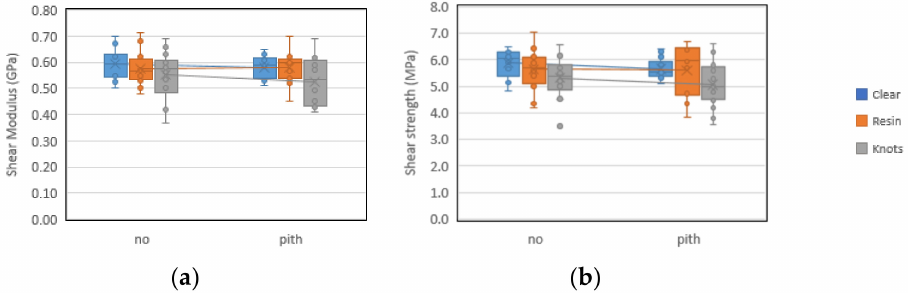
Figure 26. Box plots of shear properties with and without pith—( a ) shear modulus and ( b ) shear